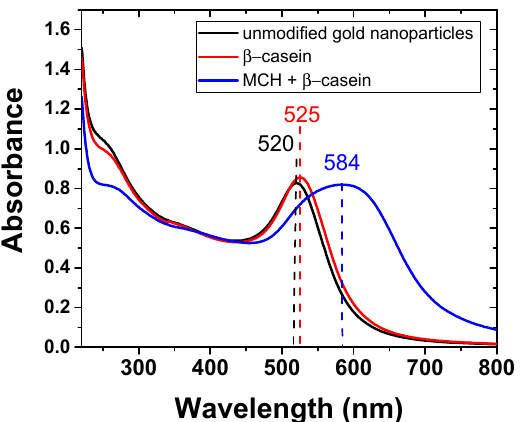
Figure 3. Absorption spectra of unmodified gold nanoparticles (AuNP) (black) and those modified by β -casein (red) and by β -casein + MCH (blue). The numbers at upper part of absorption peaks are wavelengths in nm.